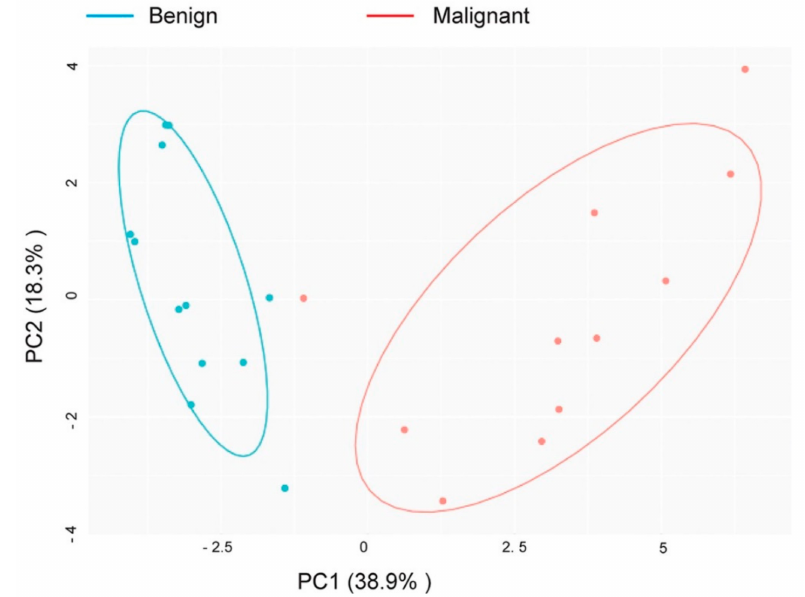
Figure 2. Principal component analysis (PCA) of patient-derived malignant and benign samples. Data from malignant and benign samples supported the pathological sample classification as malignant or benign since the sample were separable along the principal component 1 (PC1) of a principal component analysis (PCA) of their pairwise correlation. Their separability allowed identification of di ff erentially expressed biomarker candidates to distinguish between benign and malignant